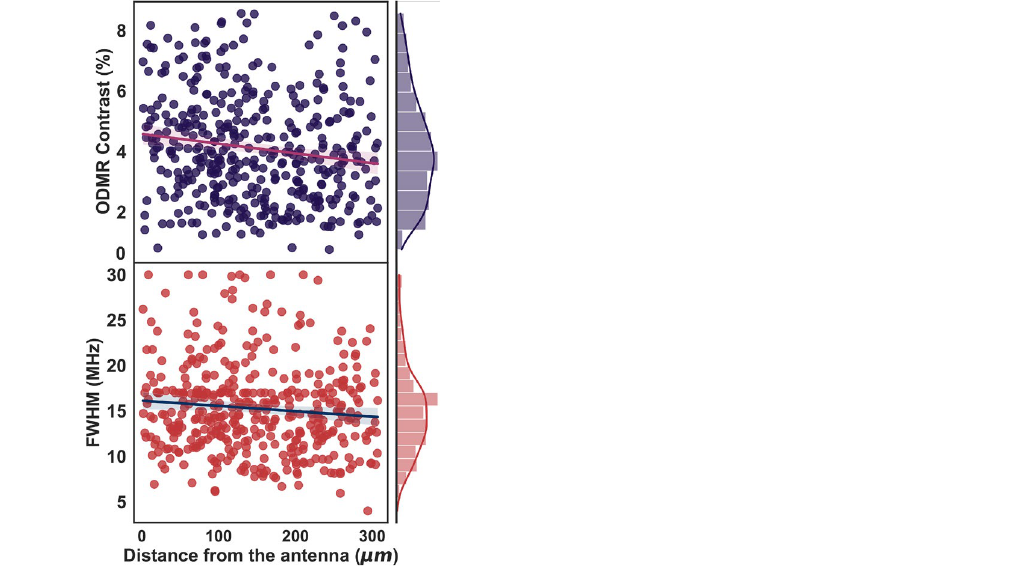
Figure 2. ODMR contrast (top panel), and FWHM (bottom panel) of all diamond spots as a function of the distance from the MW antenna. The side panels show the histogram plotted with the kernel density